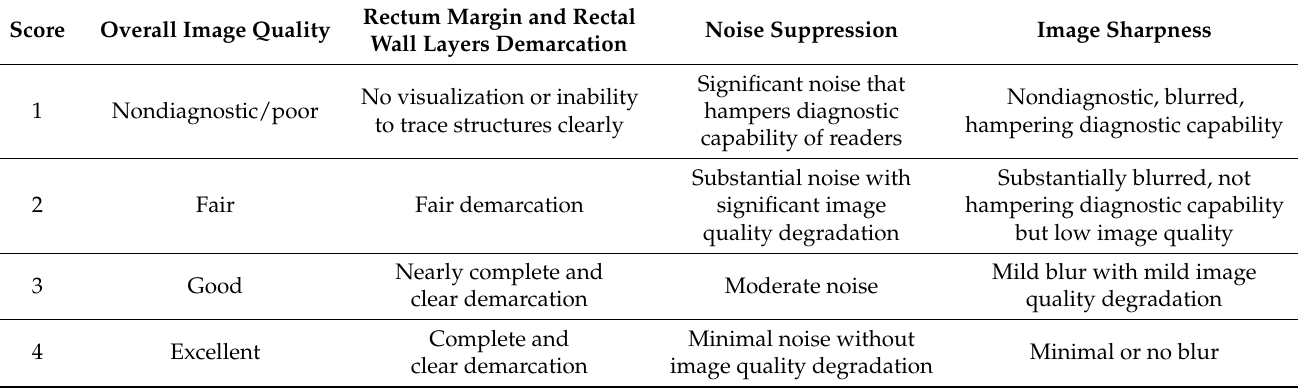
Table 1. Qualitative image evaluation criteria used by expert body